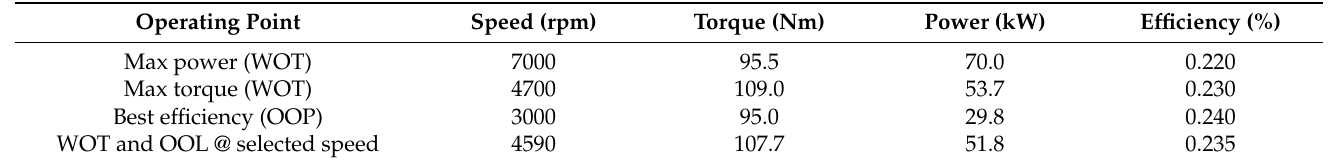
Table 1. Relevant engine working